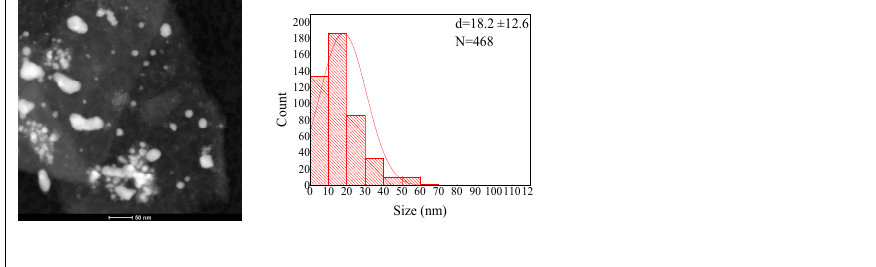
Figure 6. STEM image and particle-size distribution of the catalysts before and after reactions. d = average diameter; N = number of particles.